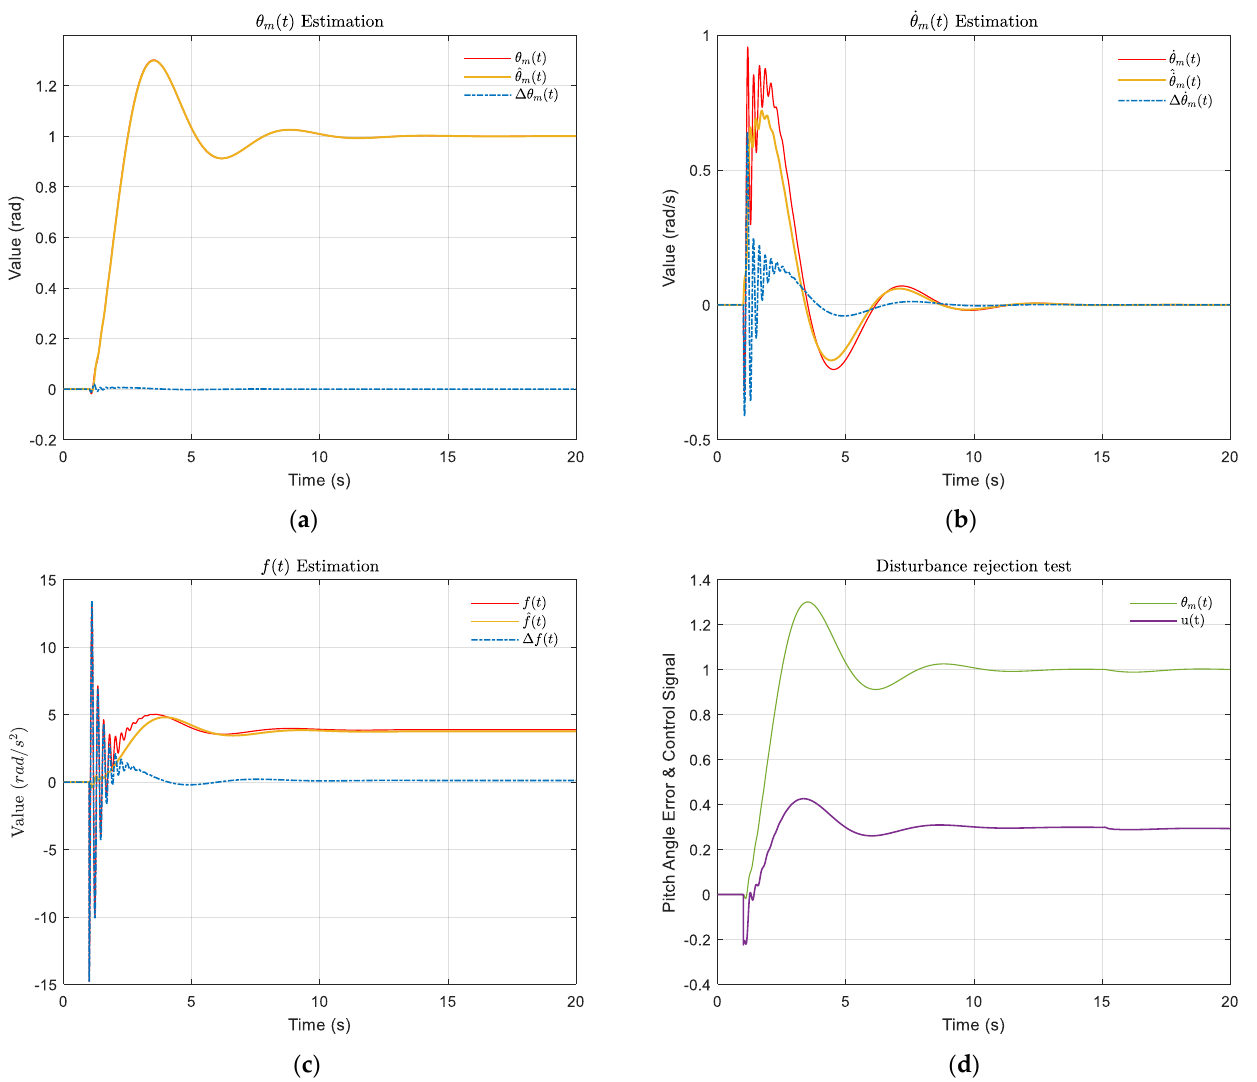
Figure 9. The estimated effects of ESO on states, and the disturbance rejection test. ( a ) The estimation of 𝜃 𝑚 (𝑡) ; ( b ) The estimation of 𝜃̇ 𝑚 (𝑡) ; ( c ) The estimation of 𝑓(𝑡) (the red solid-lines are real values; the yellow solid-lines are estimated values; the blue dotted-lines are the difference between real and estimated values.) ( d ) The disturbance rejection test result, the curve of pitch angle (green) and control signal